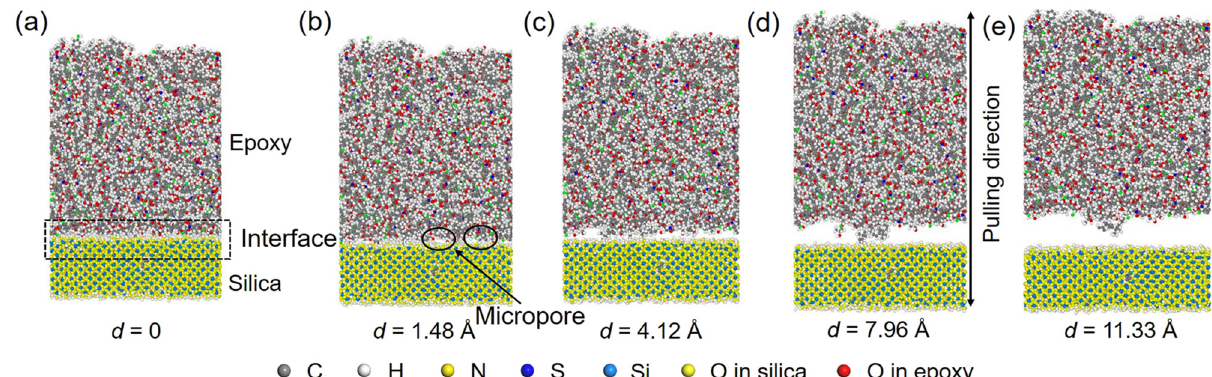
Figure 8: The structural evaluation of the interface in the epoxy/silica with hydroxyl groups. ( a ) The initial equilibrated system; ( b ) the generation of micropores; ( c ) the generation and growth of micropores; ( d ) the conformation at the point of PMF peak where the interface fails at the contact surface between epoxy and silica; and ( d ) the conformation when the epoxy and silica are completely